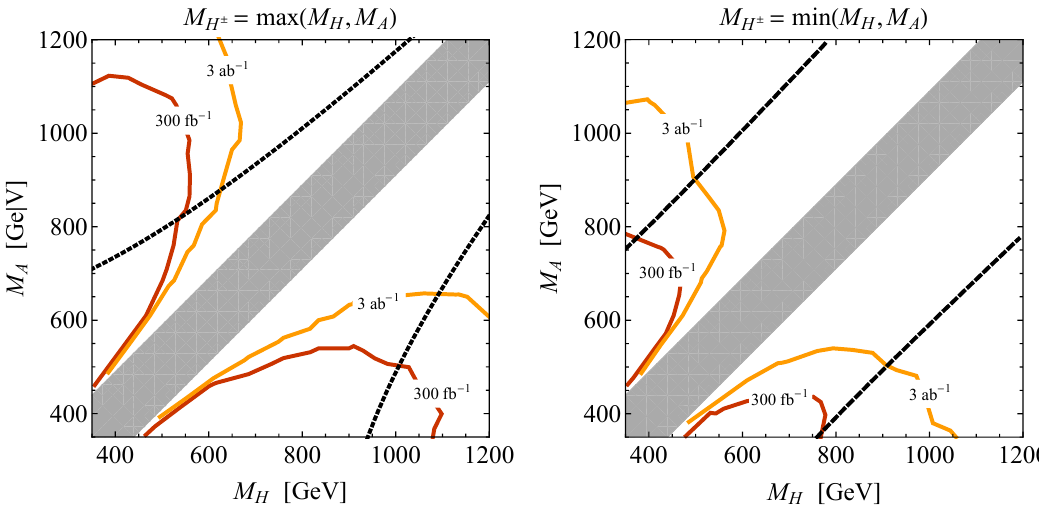
Figure 9 . Hypothetical constraints in the M H { M A plane arising from the proposed t (cid:22) tZ analysis. The given results correspond to the type-II 2HDM and adopt c (cid:12) (cid:0) (cid:11) = 0, t (cid:12) = 1, M = max ( M H ; M A ) (left panel) and M = min ( M H ; M A ) (right panel). The parameter H (cid:6) H (cid:6) space below and the left of the red (yellow) contours are excluded at 95% CL assuming 300 fb (cid:0) 1 (cid:0) (cid:1) 3 ab (cid:0) 1 of 14 TeV LHC data. The regions in the M H { M A plane that are kinematically inacces- sible through pp ! H=A ! A=HZ ! t (cid:22) tZ are depicted in grey. The dotted (dashed) black curves in the left (right) panel represents the combined constraint from perturbativity and vacuum stabil- ity (the parameter region where max ((cid:0) H =M H ; (cid:0) A =M A ; (cid:0) =M ) > 30%). See text for further H (cid:6) H (cid:6)